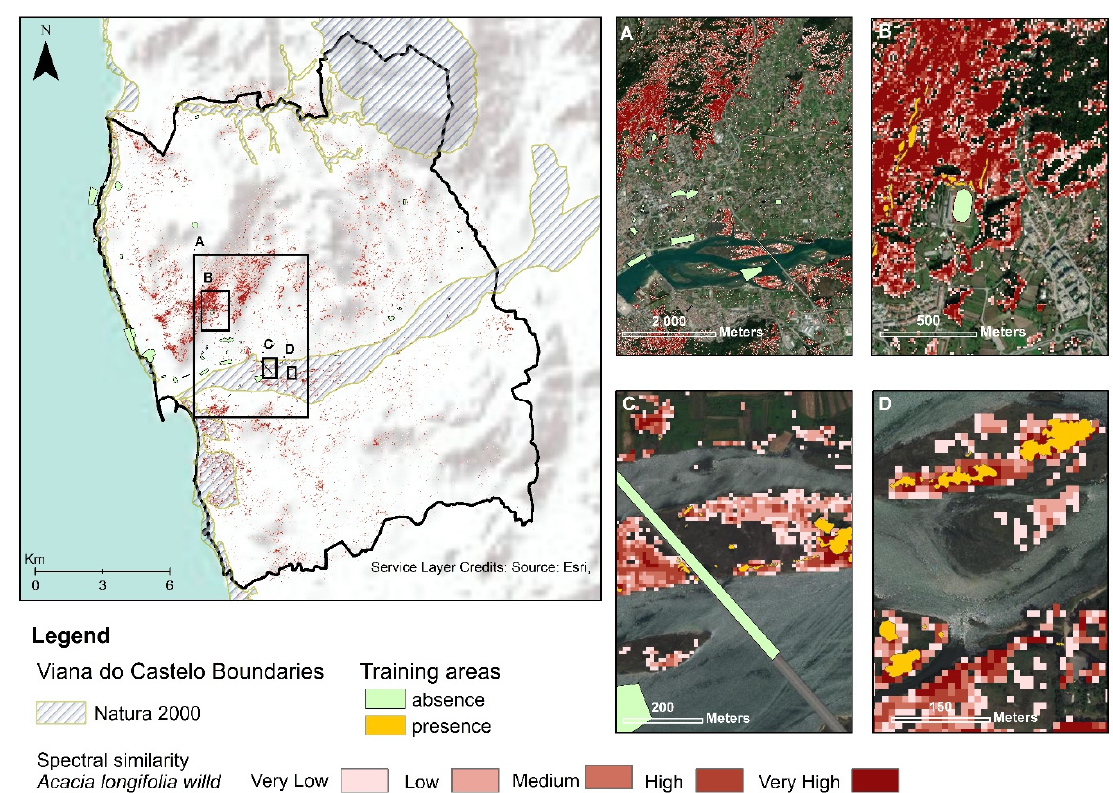
Figure 5. Map showing the distribution of invaded areas by the target species (colored pixels) obtained by the ensemble